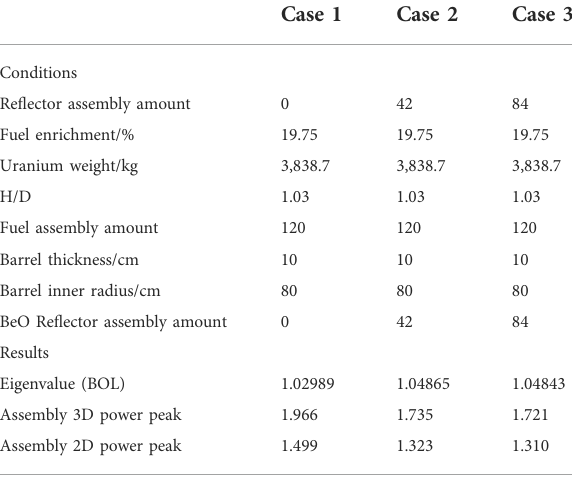
TABLE 3 Conditions and results of the re fl ector assembly amount analysis.